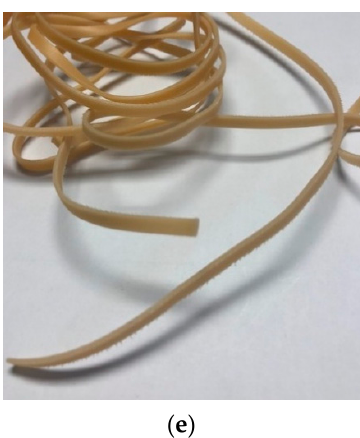
Figure 1. Appearance of BM films ( a , b ), BM SMART film ( c ) and E-BM SMART film ( d ). The diameter of films is about 150 mm and the thickness 150 μ m. ( e ) extruded strand of E-BM SMART recovered from a mini-extruder.